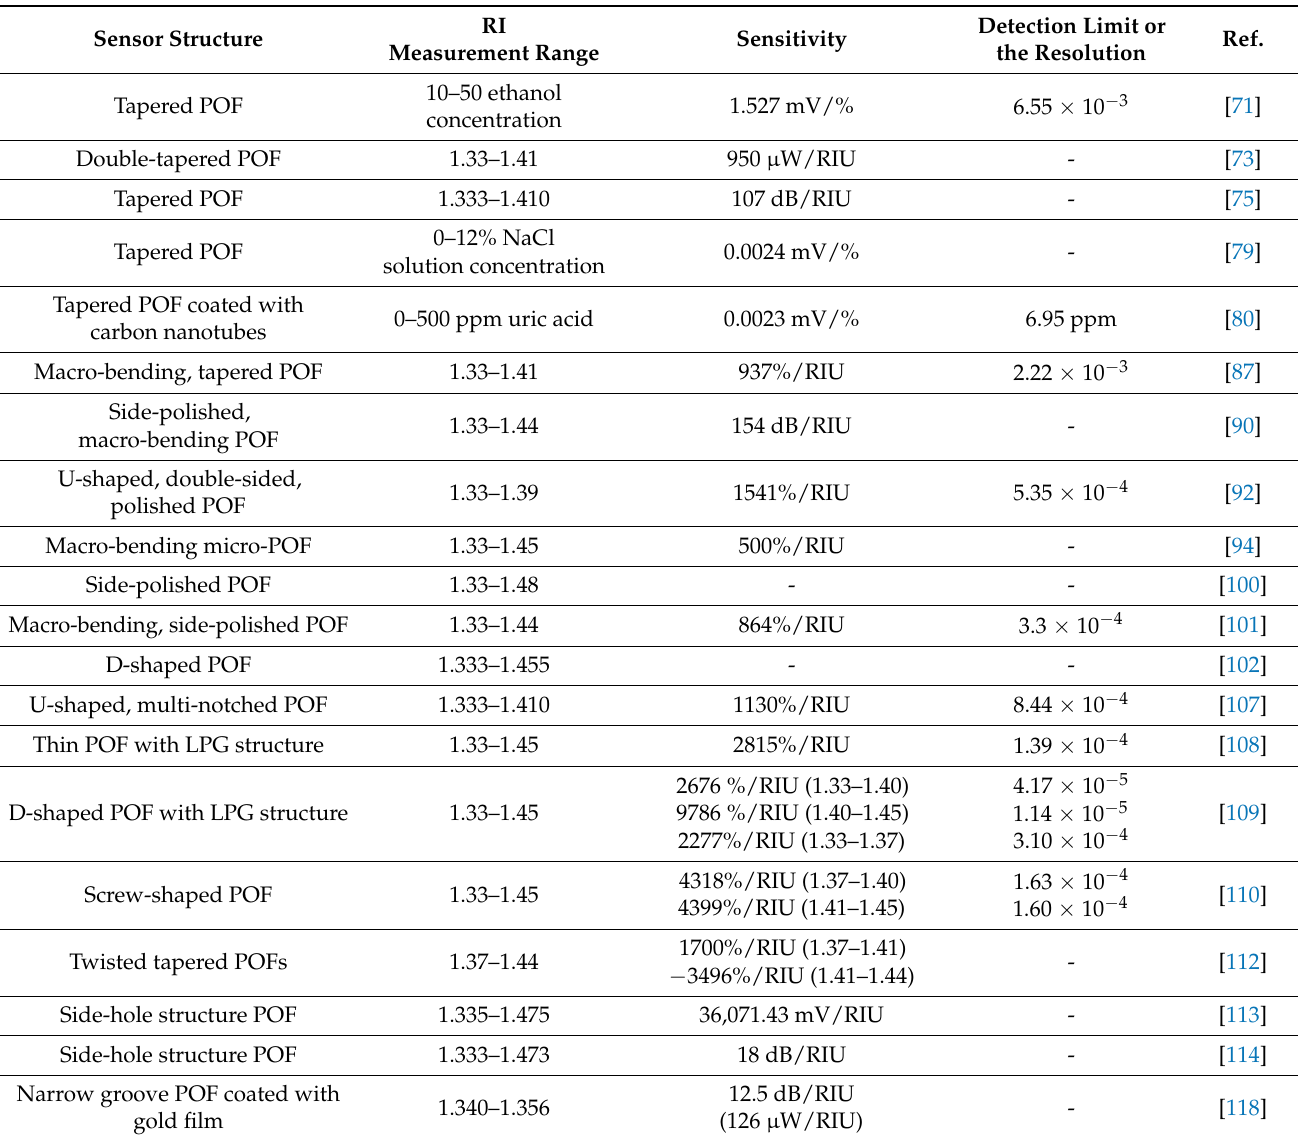
Table 1. Review of various structures of POF-based RI